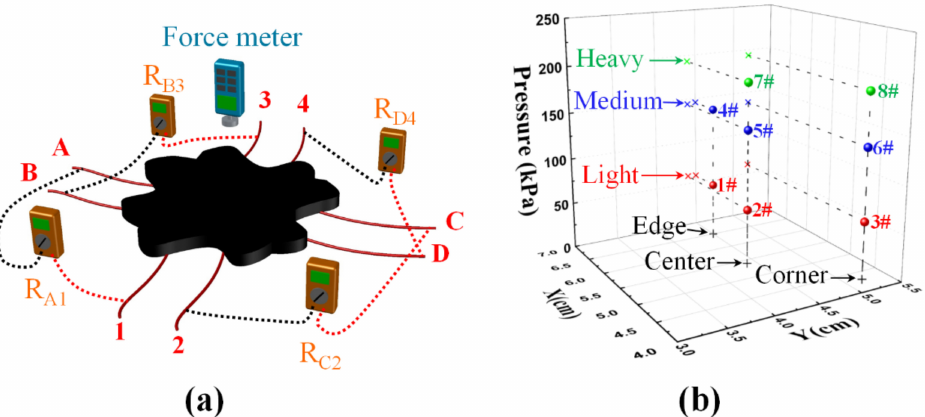
Figure 2. ( a ) Schematic diagram of the measurement system; ( b ) three-dimensional mapping of the pressure and localization of 8 typical data